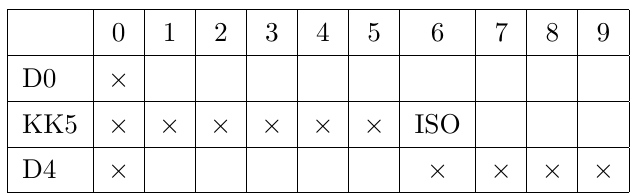
Table 3 . 1 -BPS brane intersection underlying the Abelian T-dual solution. The D1-branes become 4 D0-branes, the D3-branes become D4-branes wrapped on y and the NS5-branes become KK5- monopoles with y Taub-NUT